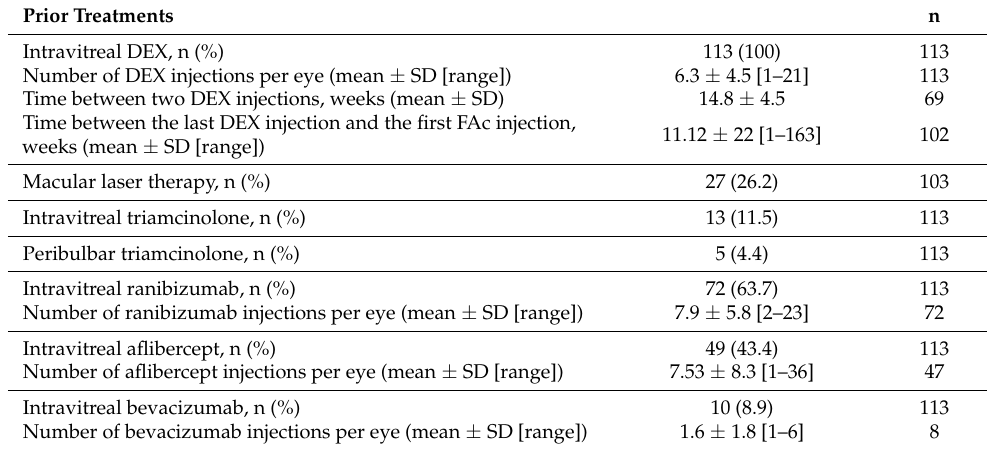
Table 2. Treatments for diabetic macular edema received prior to fluocinolone acetonide intravitreal injection. DEX, dexamethasone implant; FAc, fluocinolone acetonide implant; SD, standard deviation.